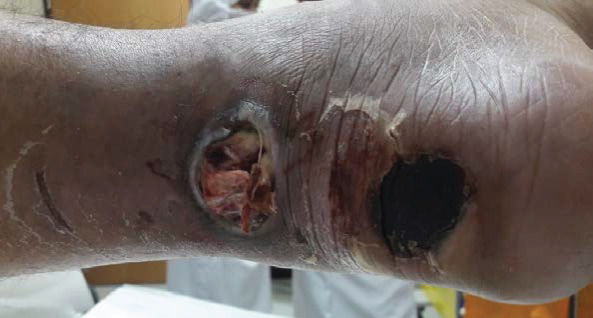
Wound presentation.